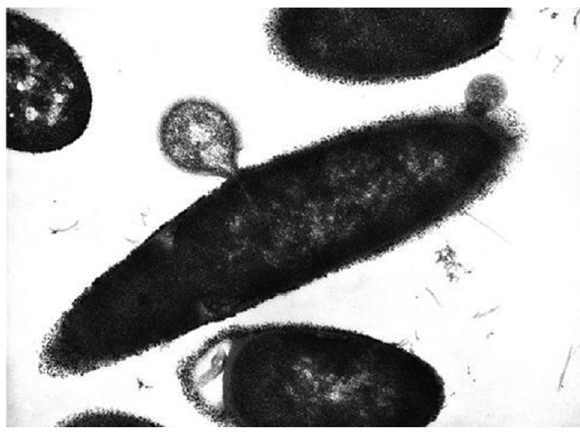
Figure 2: Lysine - a ff ected bacillus displaying attribution of the cytoplasmic membrane [ 49 ] .